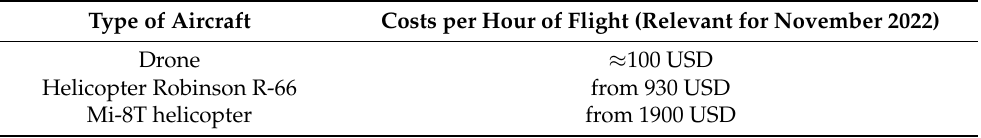
Table 4. Classification of UAVs [51].